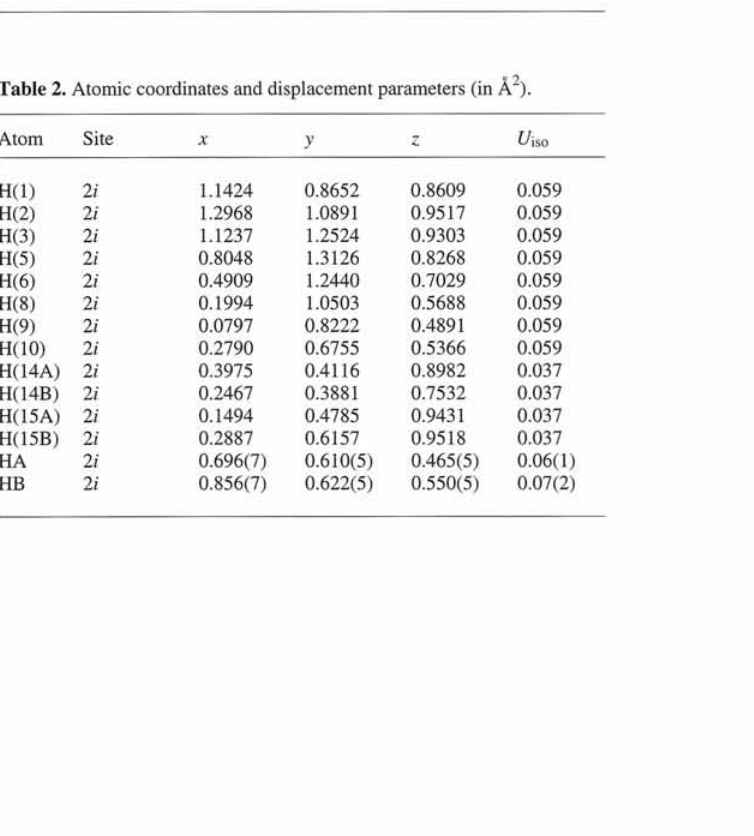
Table 1. Data collection and